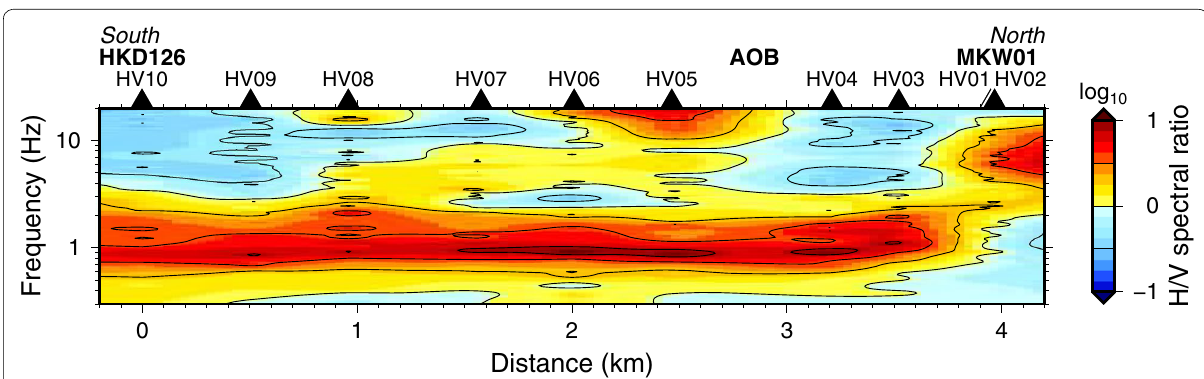
Fig. 12 Contour diagram of the horizontal to vertical Fourier spectral ratios of the single station microtremor observations. Left to right in this figure correspond to south to